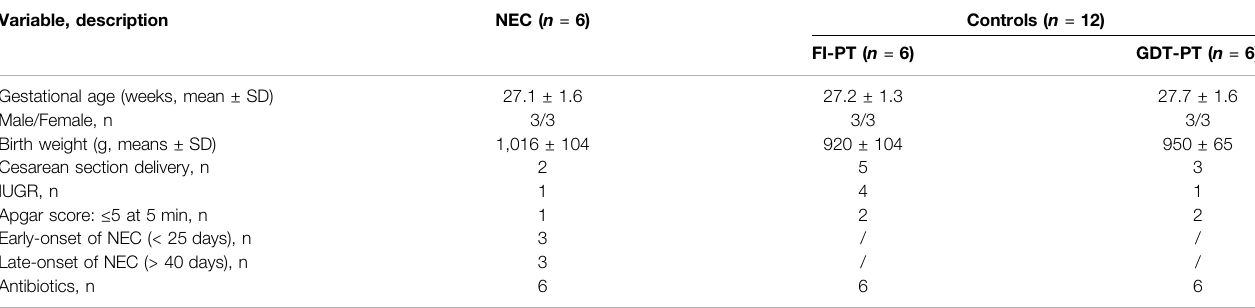
TABLE 1 | Characteristics of study